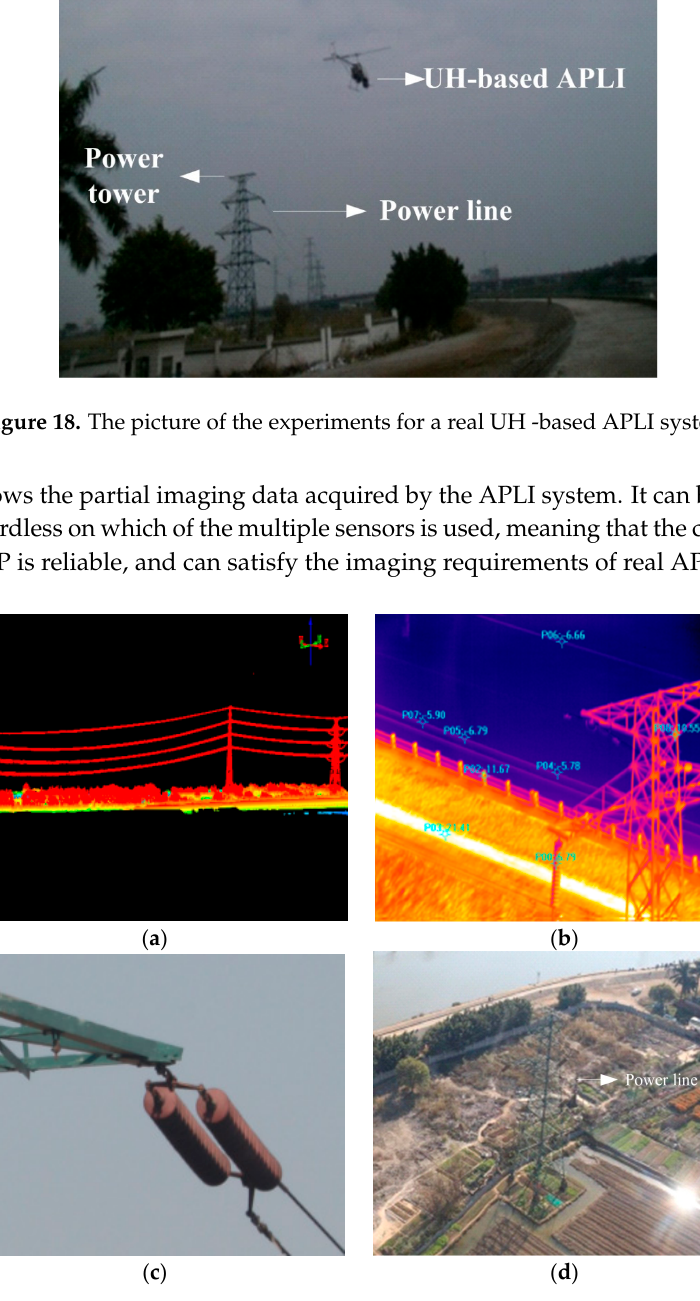
Figure 19. The partial real imaging data acquired by the APLI system using: ( a ) laser scanner; ( b ) infrared scanner; ( c ) CCD short focal distance camera; ( d ) telephoto camera.